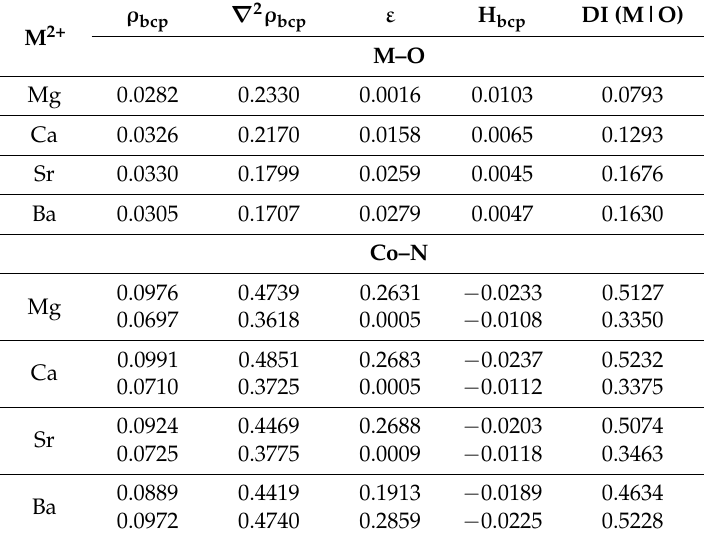
Table 2. Properties of the bond critical points, and delocalization of M–O and Co–N interactions.